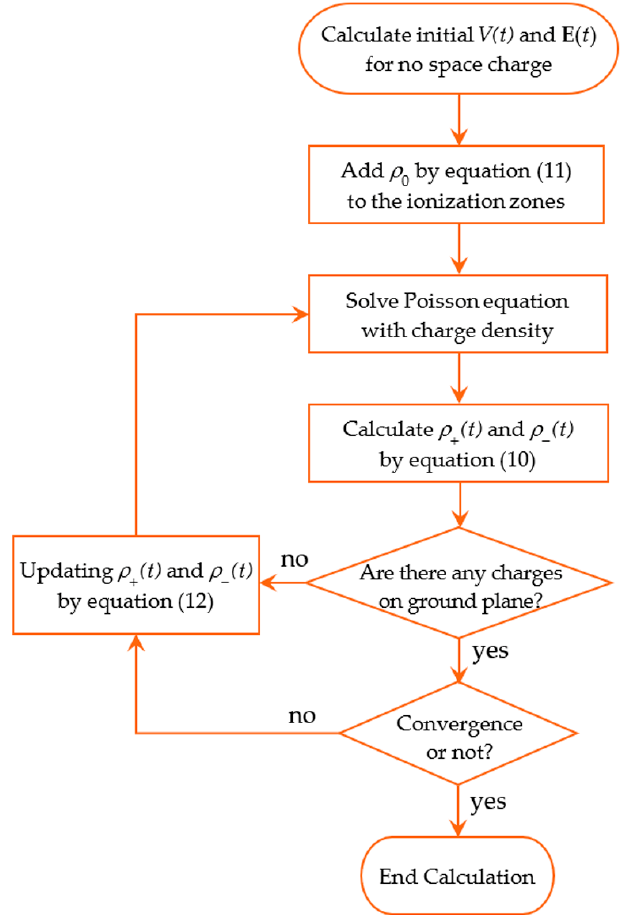
Figure 4. Flow chart of the simulation.